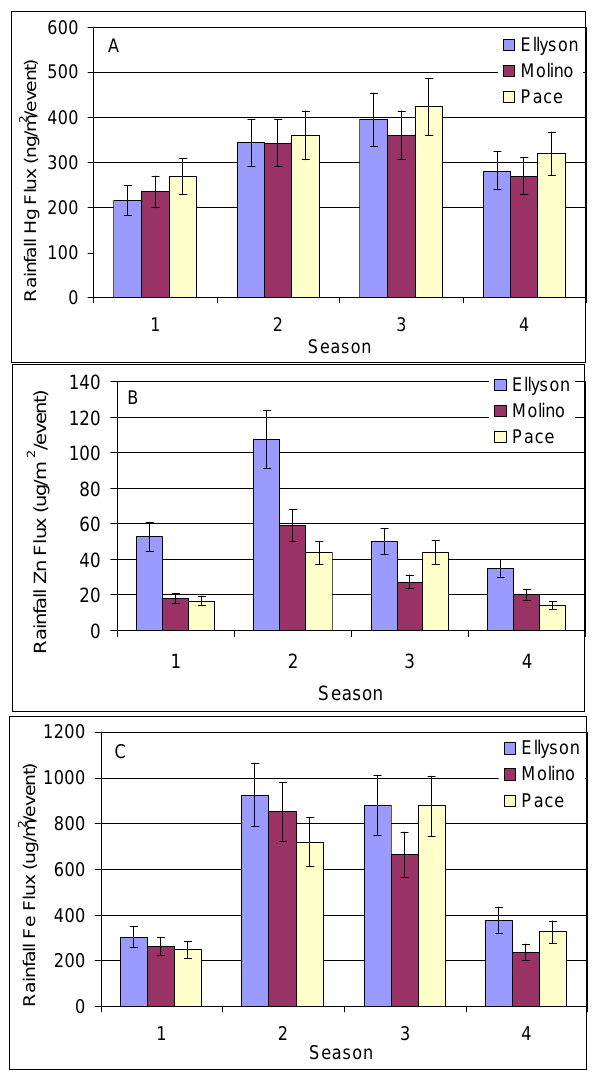
Fig. 4. Seasonal comparisons of rainfall fluxes at the three sampling sites in the Pensacola area for Hg (A) , Zn (B) , and Fe (C) . Season 1: December–February. Season 2: March–May. Season 3: June– August. Season 4: September–November. Error bars are ± 1SD of the 3-year mean